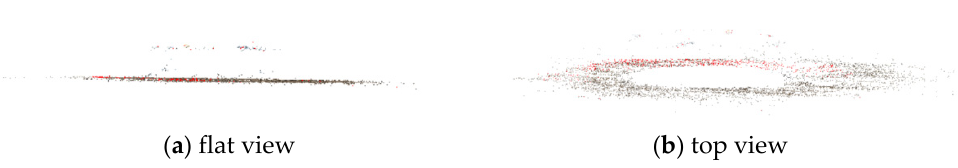
Figure 6. The sparse point cloud of the scene. ( a ) is the flat view of the pont cloud. ( b ) is the top view of the point cloud.